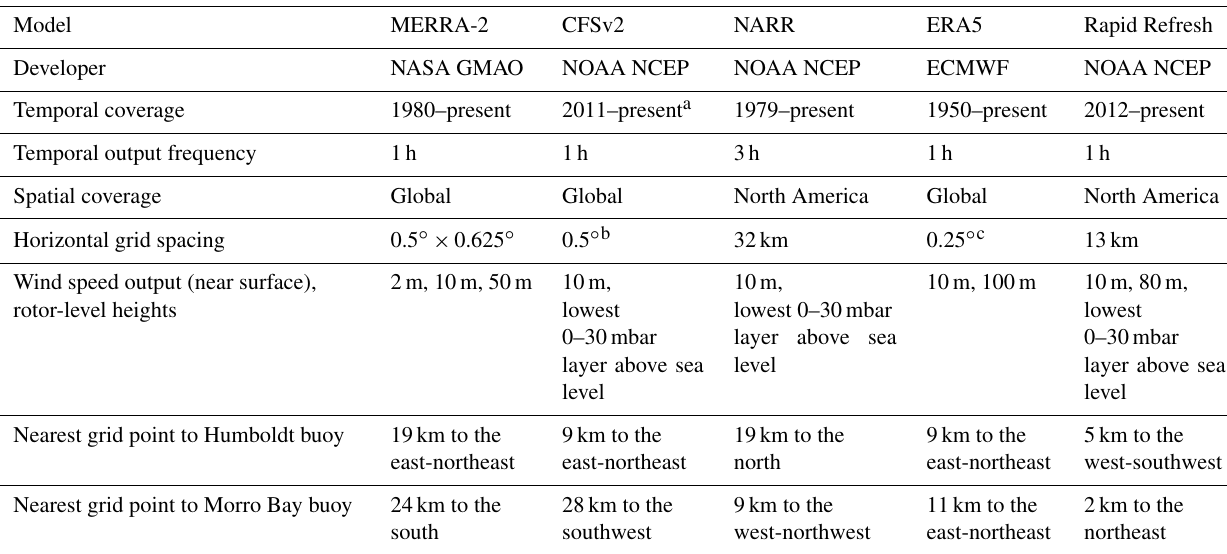
Table 2. Characteristics of the models that produce rotor-level wind speed estimates.